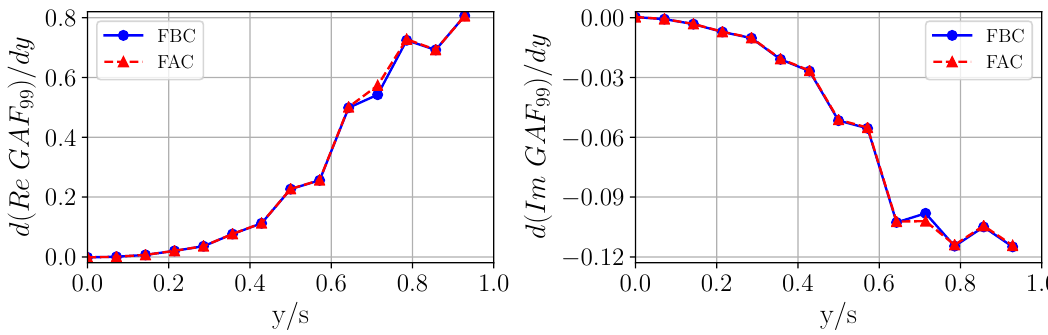
Figure 25. Comparison of the FBC and the FAC with regard to the resulting wing section contribution to GAF 77 , GAF 79 , GAF 97 , GAF 99 at k red = 0.2.